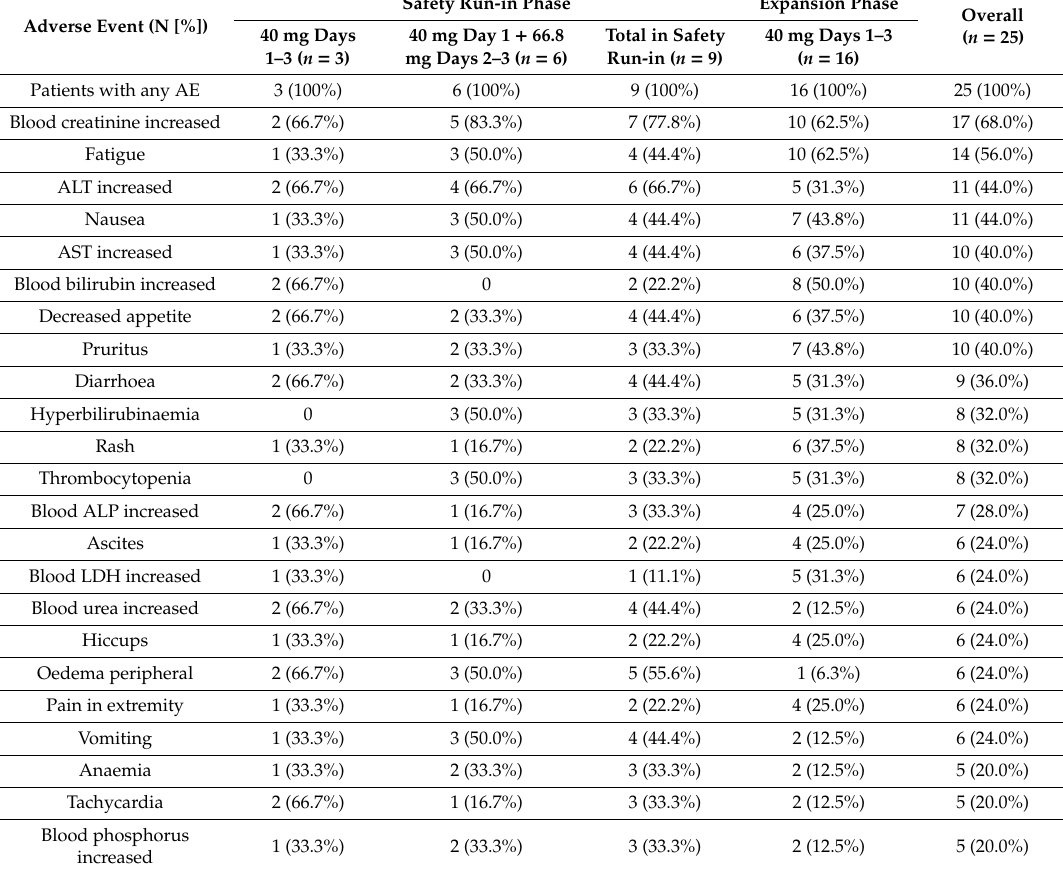
Table 2. Events occurring in ≥ 20% of patients in descending order of